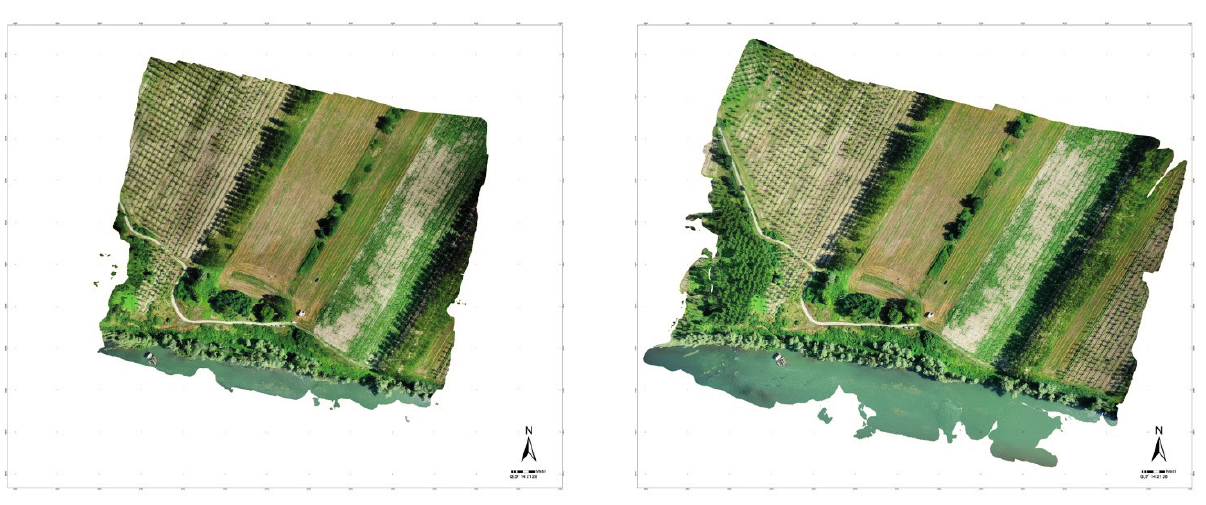
Figure 9. Orthophoto based on the images acquired with the multi-rotor UAV: 70-m flight height ( left ) and 150-m flight height ( right ).